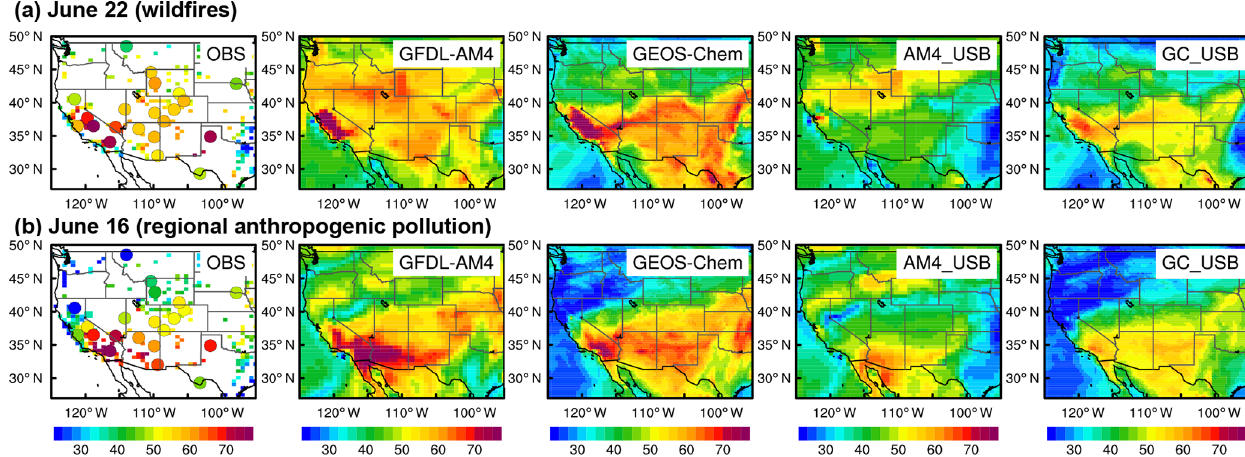
Figure 12. Same as Fig. 9 but for (a) the wildfire event on 22 June and (b) the regional anthropogenic pollution event on 16 June 2017.